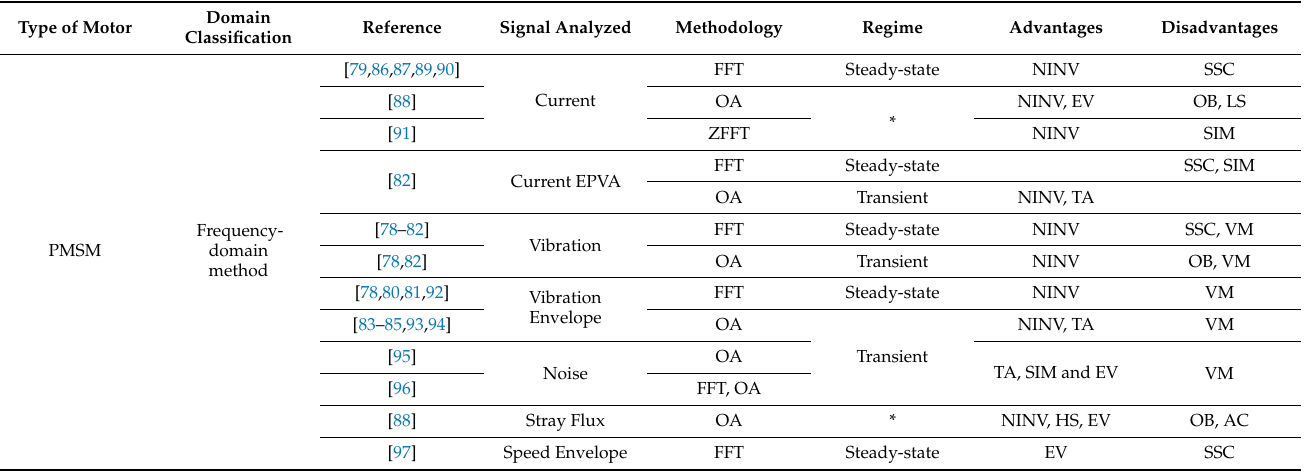
Table 3. Classification of detection methods for bearing faults in